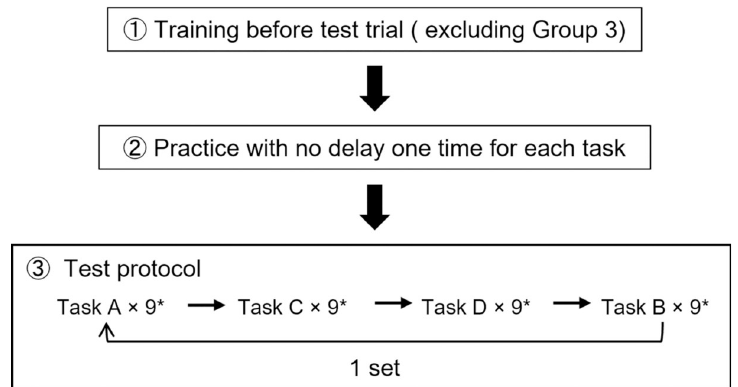
Fig 1. Actual protocol. A total of 4 sets were performed, with the last 2 sets performed on different days. � Each task was performed 9 times with different delay settings, as follows: Delay 0 ms ! Delay 0 ms ! Delay 0 ms ! Delay